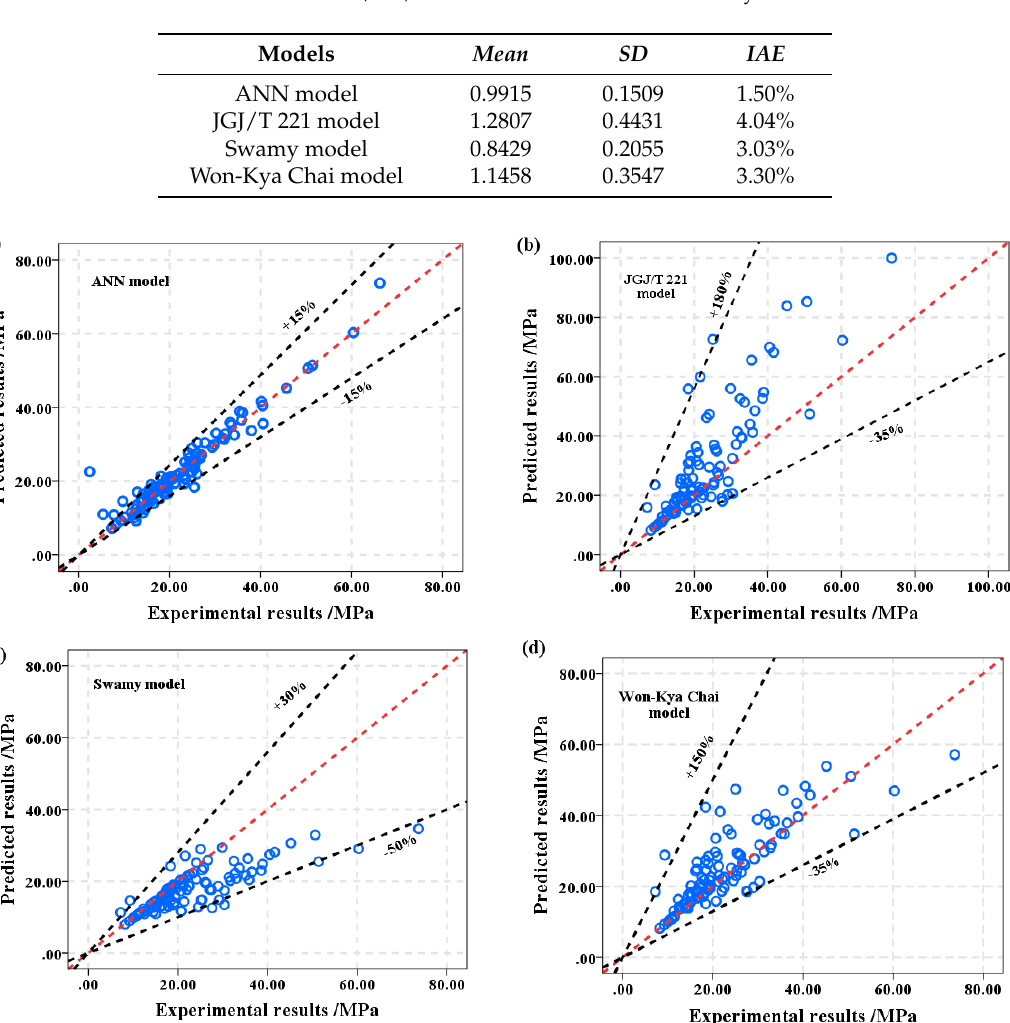
Table 10. The Mean value, SD, and IAE of ANN model and analytical models.